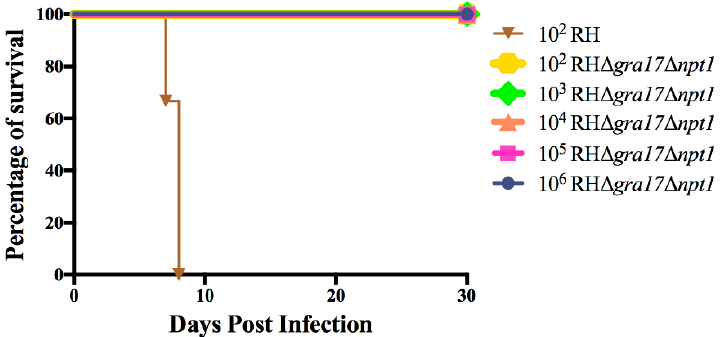
Figure 2. Virulence assays of RH ∆ gra17 ∆ npt1 in Kunming mice. Serial doses (10 2 to 10 6 ) of RH ∆ gra17 ∆ npt1 or 10 2 of wild type RH tachyzoites were i.p. inoculated into mice, and the survival rates and clinical signs were recorded for 30 days. Six mice were used per group.